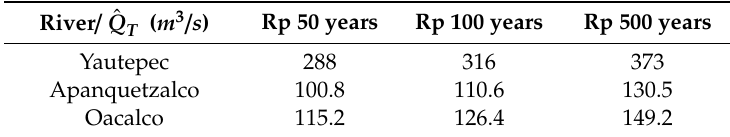
Table 2. Maximum discharge probability for di ff erent return periods (Rp).